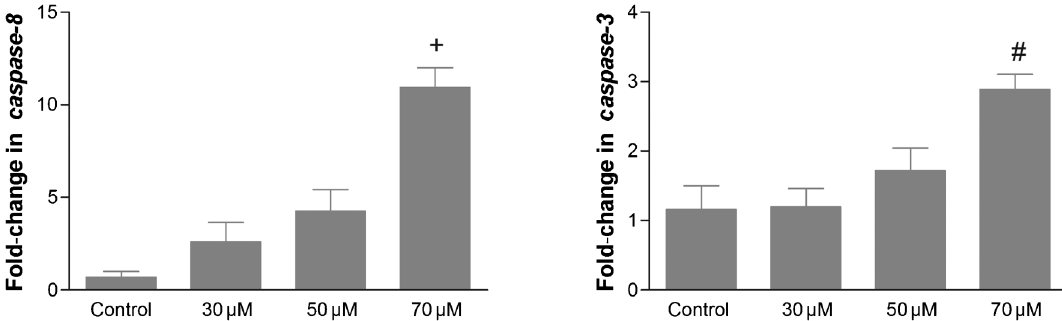
Figure 4. Caspase-3 and caspase-8 gene expression in U87 cells. The y-axis indicates the fold-change in caspase-3 and caspase-8 expression. Data are reported as means ± SD for 3 measurements. The expression levels of caspase-3 and caspase-8 were compared between cells that had been treated with different concentrations of kaurenoic acid (KA) for 48 h and untreated cells. # P , 0.0001 for 70 m M KA treatment vs control cells for caspase-3 . + P , 0.001 for 70 m M KA treatment vs control cells for caspase - 8 (Bonferroni multiple comparison test).